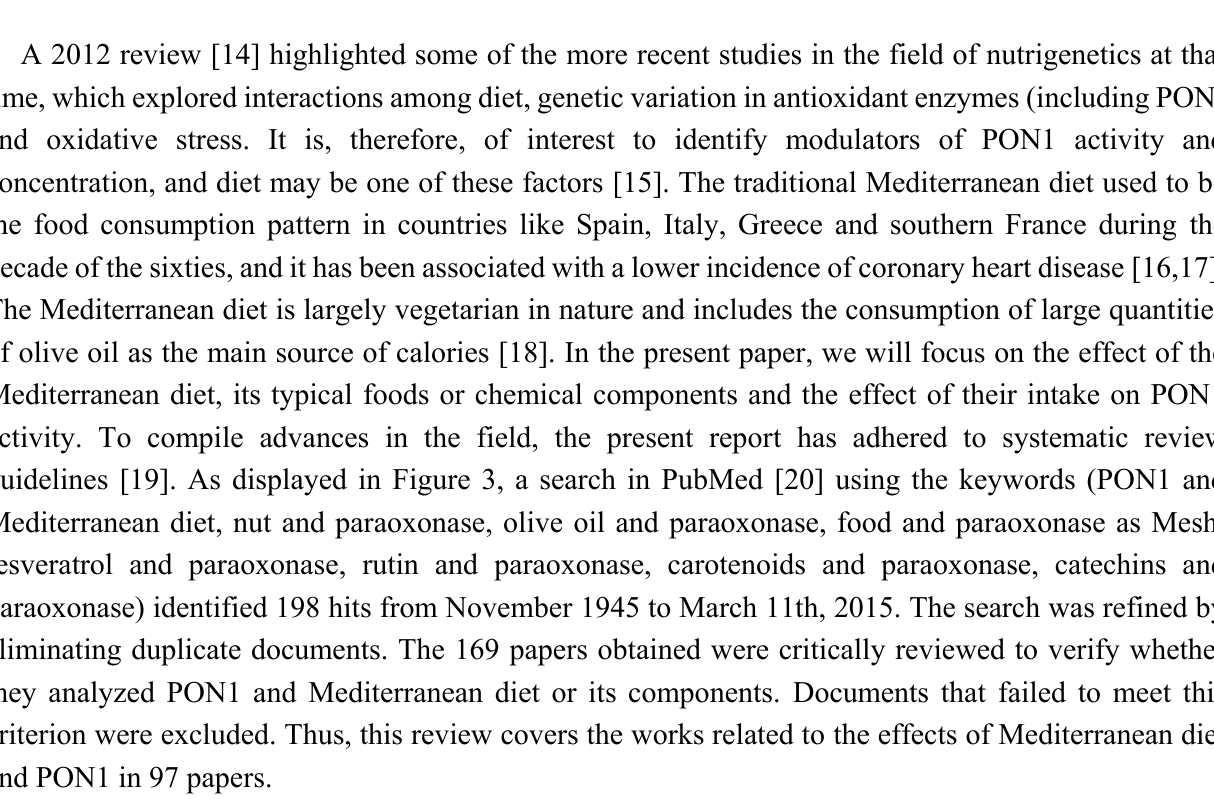
Figure 2. Effect of dietary components on regulation of paraoxonase 1 activity and its interaction with genetic factors. Adapted from [12] and [13], reproduced with permission from